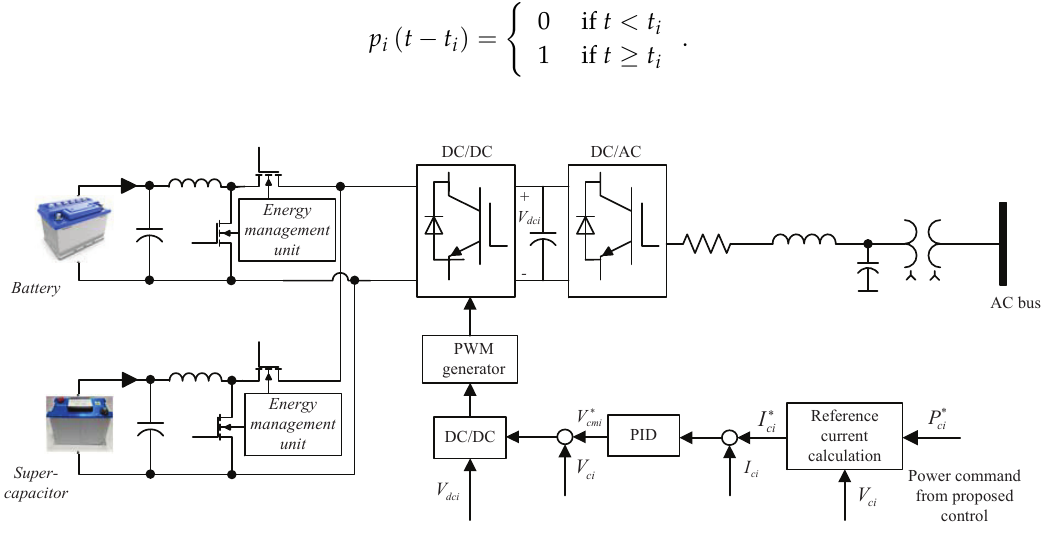
Figure 3. The basic structure of the